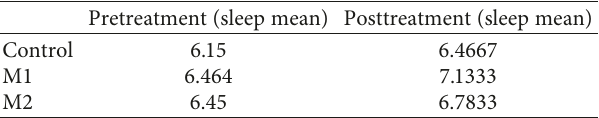
Table 7: Pretreatment and posttreatment sleep time mean